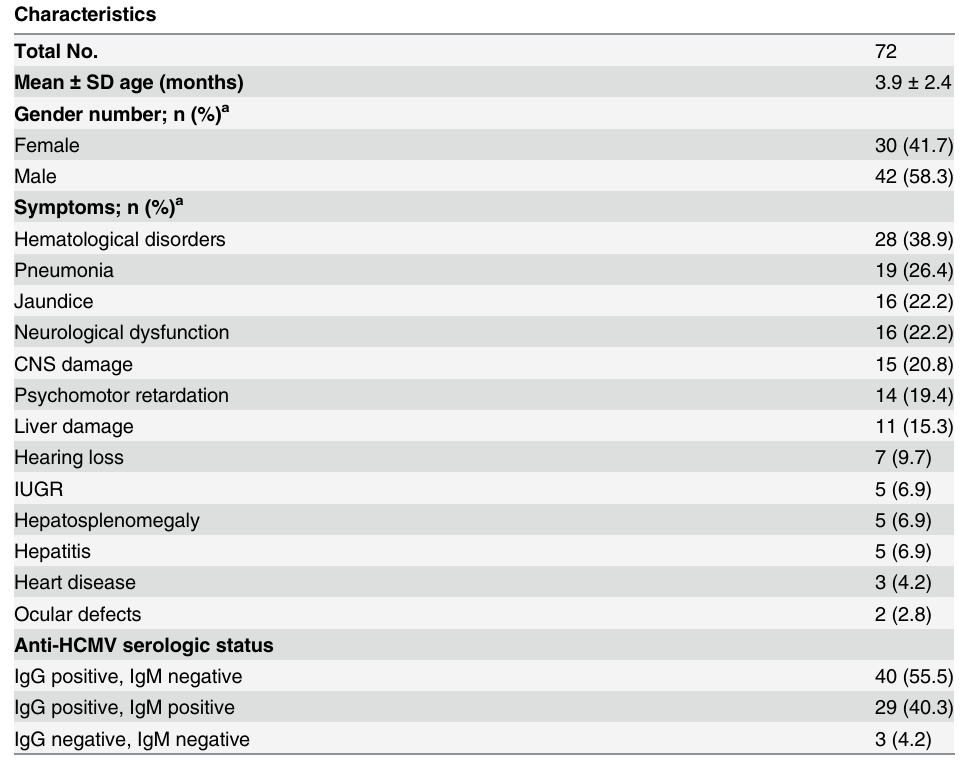
Table 1. Demographic and clinical characteristics of study subjects with HCMV infection.